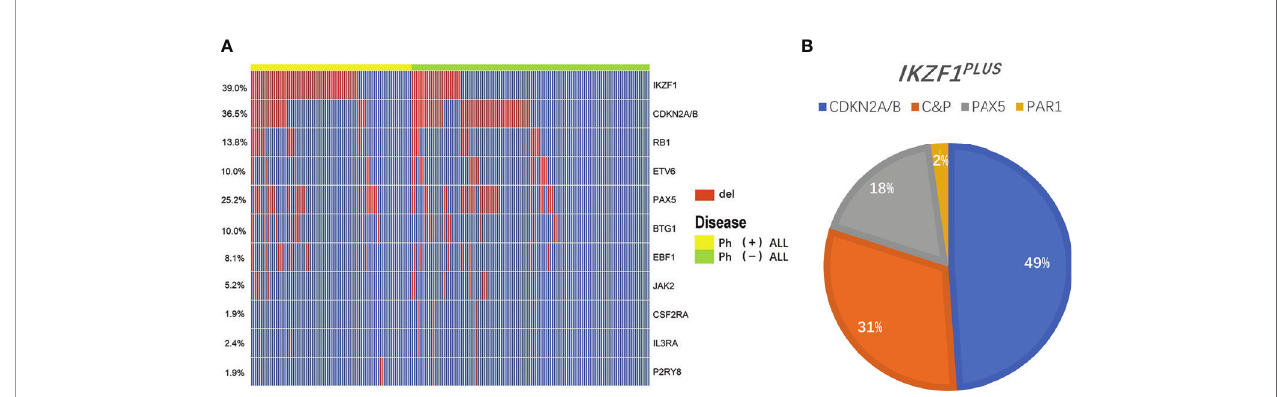
FIGURE 1 | Overview of gene deletions detected by MLPA. (A) A heatmap showing the prevalence of main gene deletions in 211 adult B-ALL. The red bar represents the patients carried the gene deletion, the blue bar represents the patients didn ’ t carry the gene deletion. (B) A pie chart depicting the proportion of speci fi c types of IKZF1 PLUS deletion. Different color represents different gene deletions in concurrence with IKZF1 deletion: Blue, CDKN2A/B (49%); Orange, C&P (CDKN2A/B and PAX5, 31%); Gray, PAX5 (18%); and Yellow, PAR1 (2%).